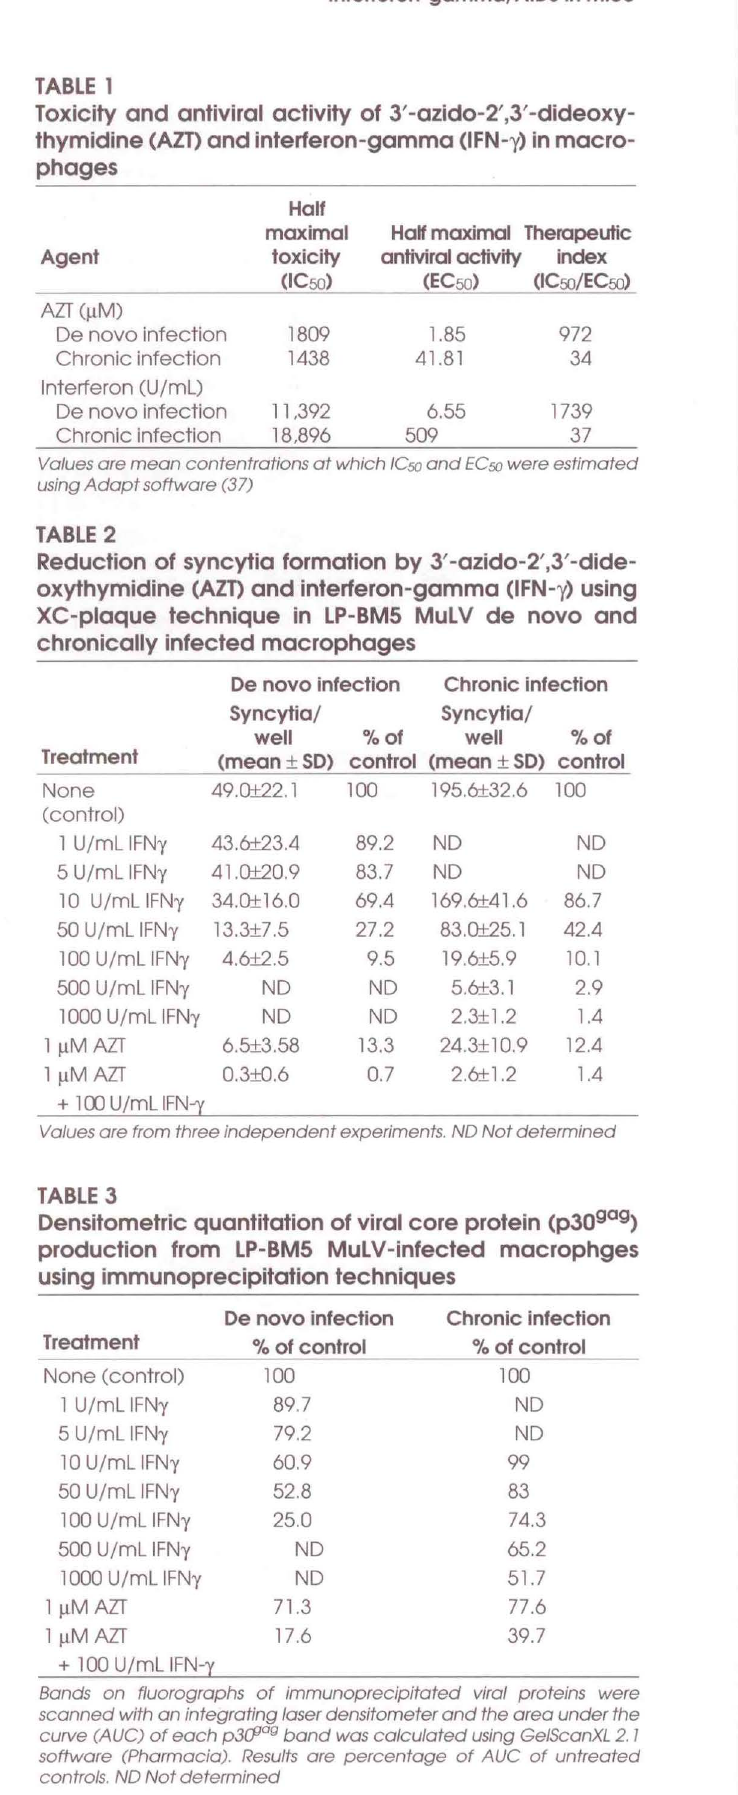
Toxicity and antiviral activity of 3'-azido-2',3'-dideoxy thymidine (AZT) and interferon-gamma (IFN-y) in macro phages